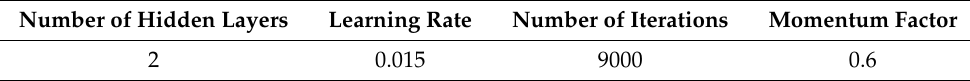
Table 7. Network parameters of BP network, PCA-BP, and SVD-BP models.